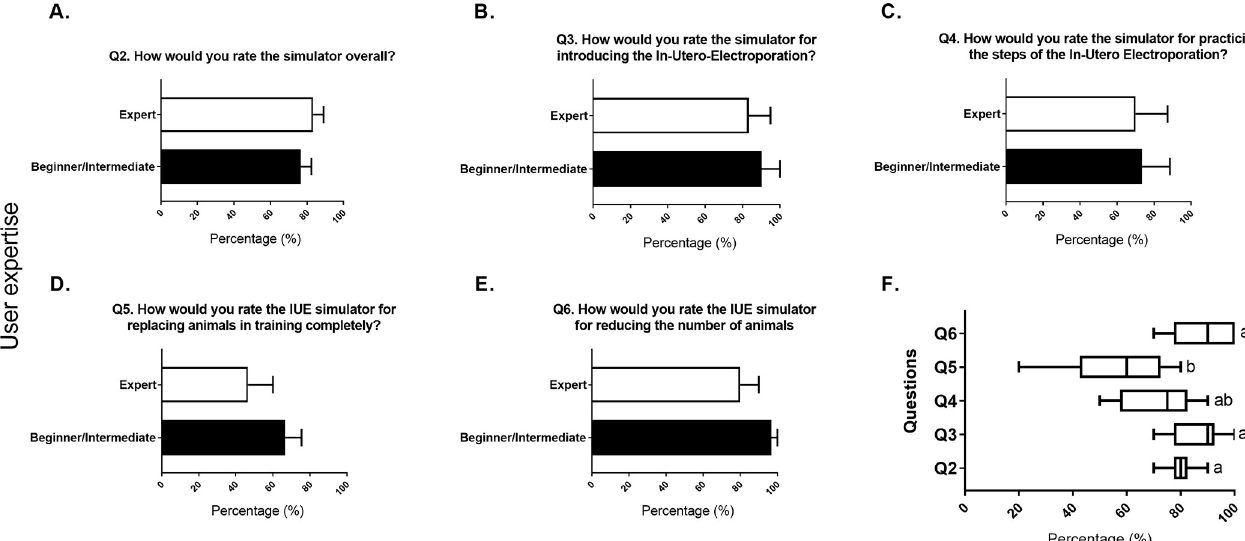
Fig 6. Evaluation of the IUE simulator. (A-E) The user responses to each of our questions to evaluate the IUE simulator. The X-axis indicates percentage points, while the Y-axis indicates the level of user experience. Statistical comparisons were made according to the ’ ’user’s level of expertise (Expert in white and beginner/intermediate in black). Student’s t-test was used for statistical comparison (n = 3). Significance was set as P-value less than 0.05. Bars in the graph represent SD. (F) indicates the statistical comparison between the questions. The X axes indicate percentage points, whereas the Y axis indicates the respective question. The one-way ANOVA followed by Tukey’s HSD (honestly significant difference) test was used for statistical comparison. Significance was set as P- value less than 0.05. Different letters indicate significant differences. Data are depicted in percentage units.